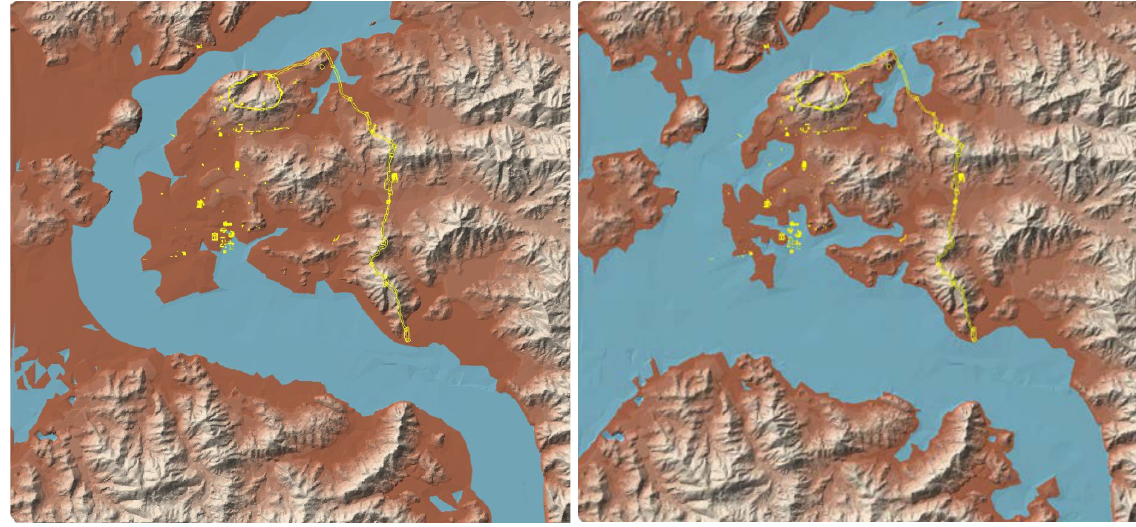
Figure 6. Ancient river boundaries during the normal tide season (water level is 6–4.5 m)